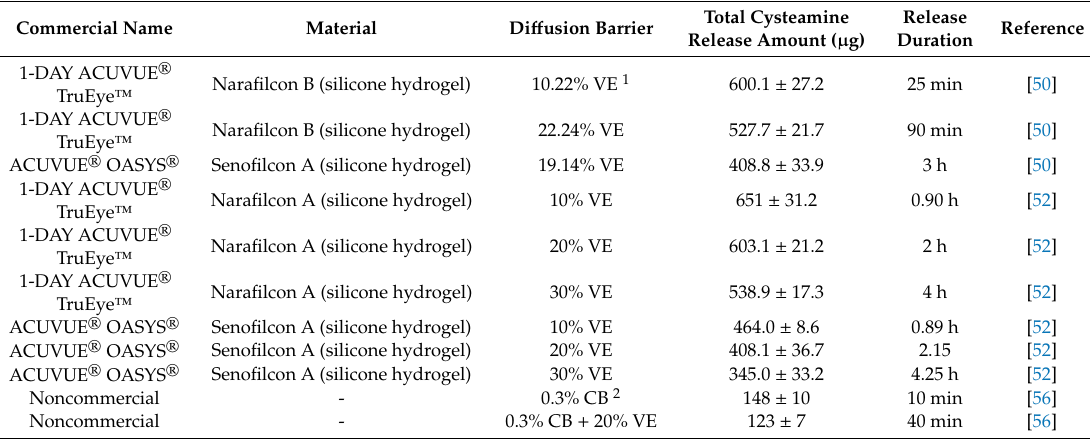
Table 2. Contact lenses developed as cysteamine delivery